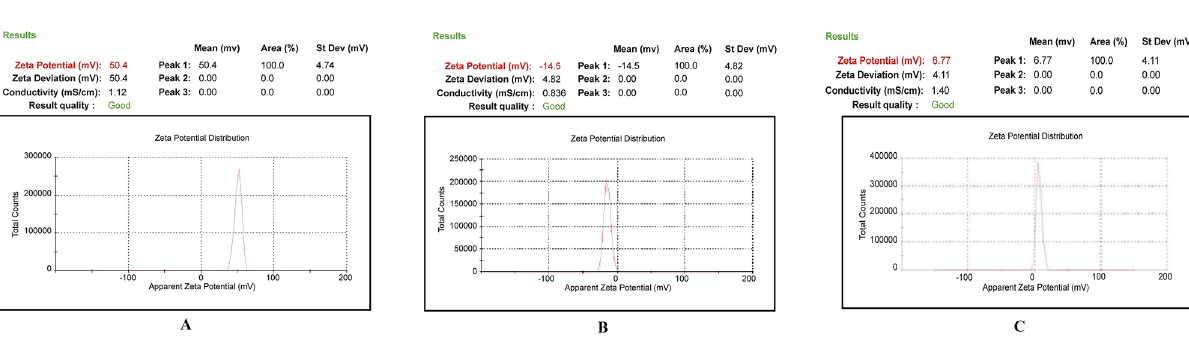
Figure 2. Physical characterization of polymer, cross linker, and monoclonal antibody. (A) Zetapotential analysis of chitosan gel (1.0% w/v). ( B ) Zetapotential analysis of tripolyphosphate (0.5% w/v). ( C ) Zetapotential analysis of rituximab (1.0%